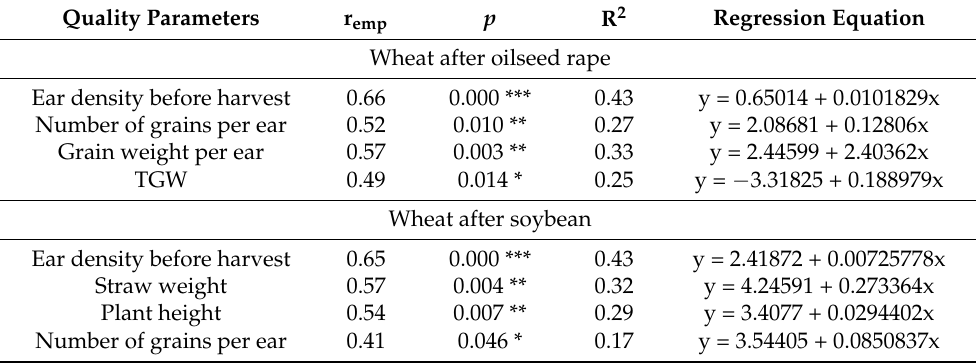
Table 4. Simple correlation coefficients, probability of significance, and simple regressions for the relationship between winter wheat yield and yield components depending on previous crop. Quality Parameters